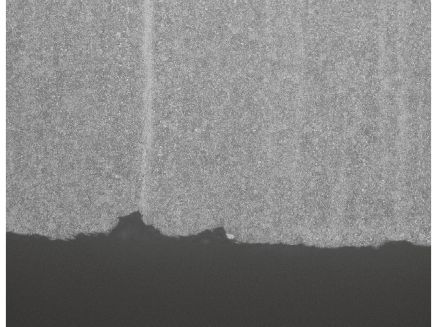
Figure 14: Micromorphology of the band.